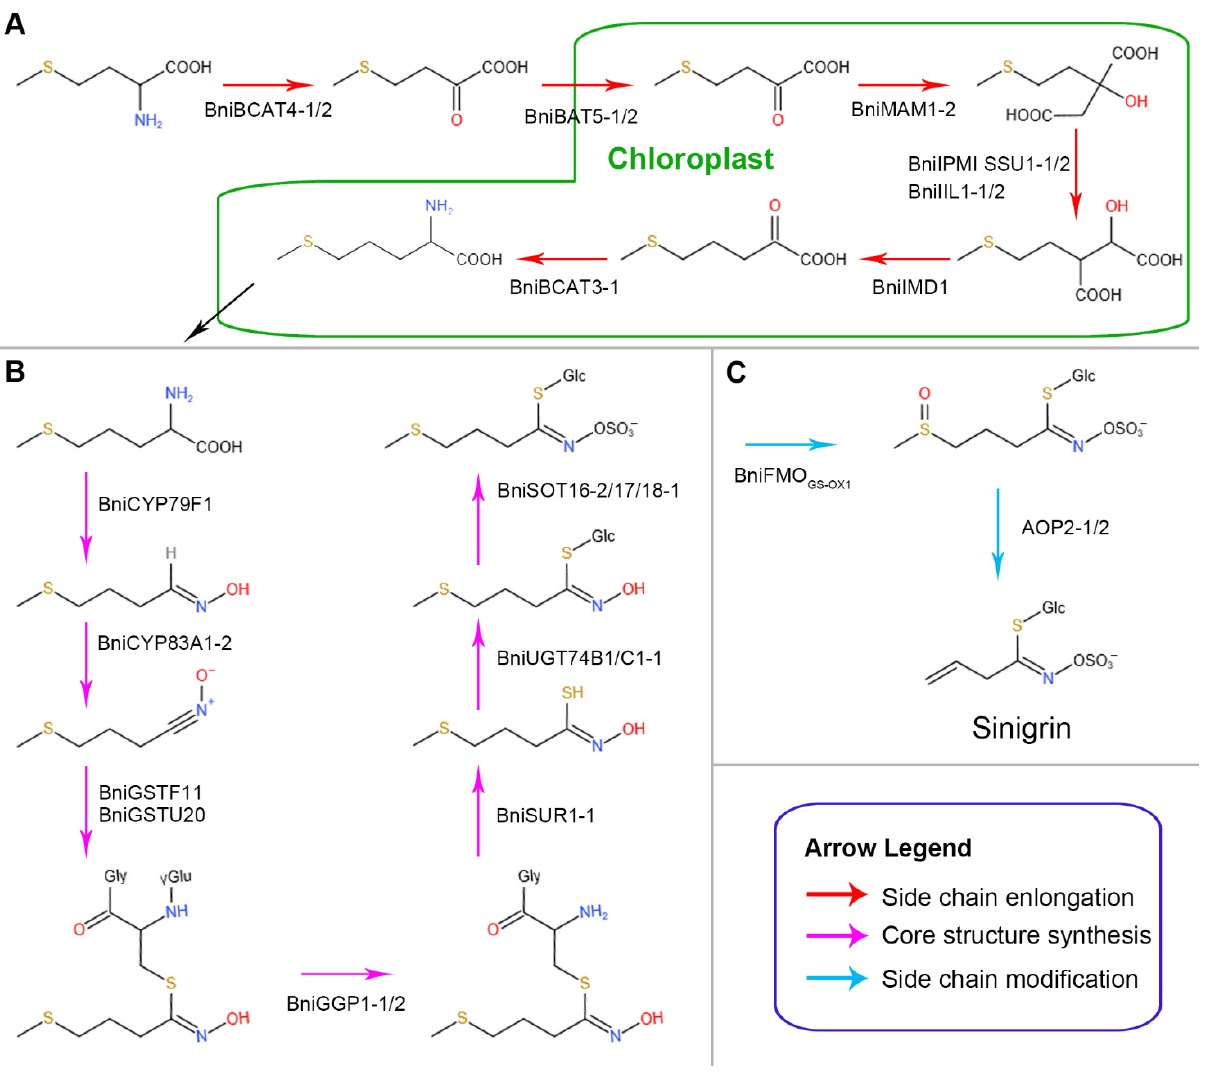
Figure 9. A pathway diagram of candidate key genes involved in sinigrin biosynthesis in B. nigra . ( A ) Side-chain elongation machinery. ( B ) Biosynthesis of core glucosinolate structure. ( C ) Secondary modification (alkenylations).